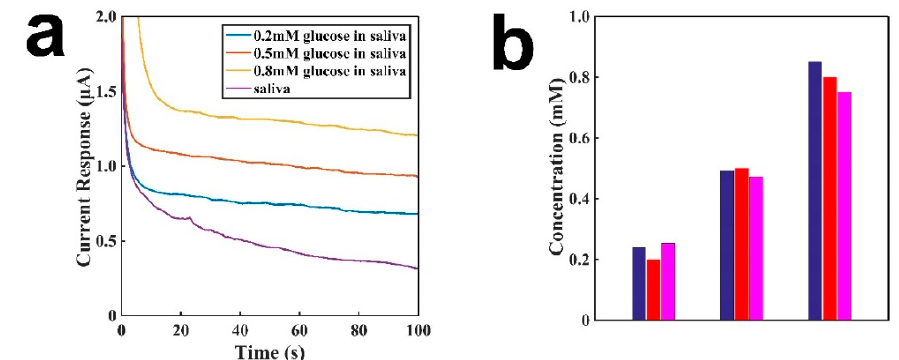
Figure 6. Comparison of the sensor and a spectrophotometer for the detection of different concentrations of glucose. ( a ) The baseline of saliva with different concentrations of glucose in saliva; ( b ) The comparison between the sensor and a spectrophotometer for the detection of different concentrations of glucose. Blue is from a spectrophotometer, red is the true concentration in saliva, and pink is from a sensor.